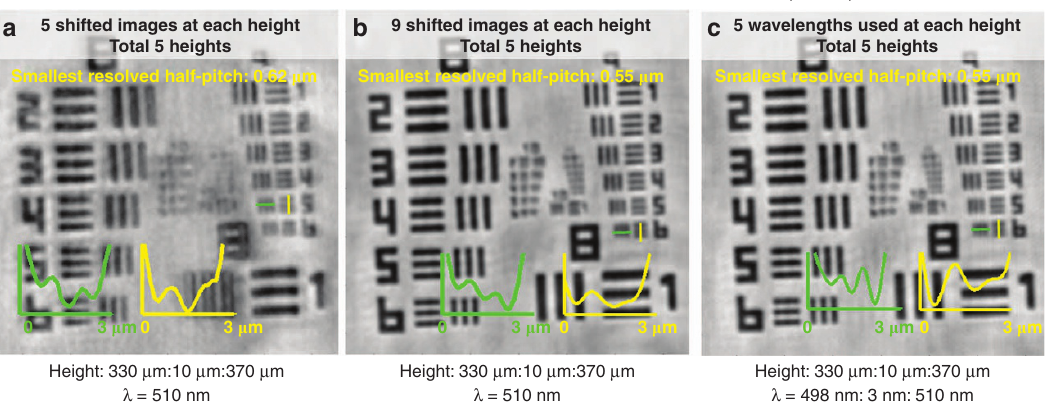
Figure 4 Lens-free imaging using multi-height phase retrieval and wavelength-scanning pixel super-resolution. Five heights are used in each case shown in a – c . ( a , b ) are lens-free reconstructions using lateral shift-based pixel super-resolution and multi-height phase retrieval. a uses fi ve and b uses nine sub-pixel-shifted raw measurements at each height. ( c ) Lens-free reconstruction using wavelength-scanning pixel super-resolution and multi-height phase retrieval; fi ve wavelengths are used with a scanning range of 498 – 510 nm and a scan step size of 3 nm.